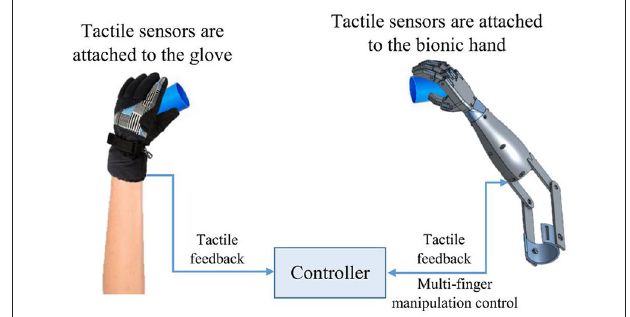
FIGURE 1 | A schematic of the proposed master-slave robot. Tactile sensors are attached to both glove and bionic hand. The controller sends the force command to the bionic hand (slave) based on the signal from the glove-mounted tactile